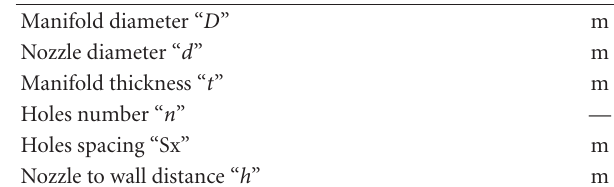
Table 1: Geometric parameter.